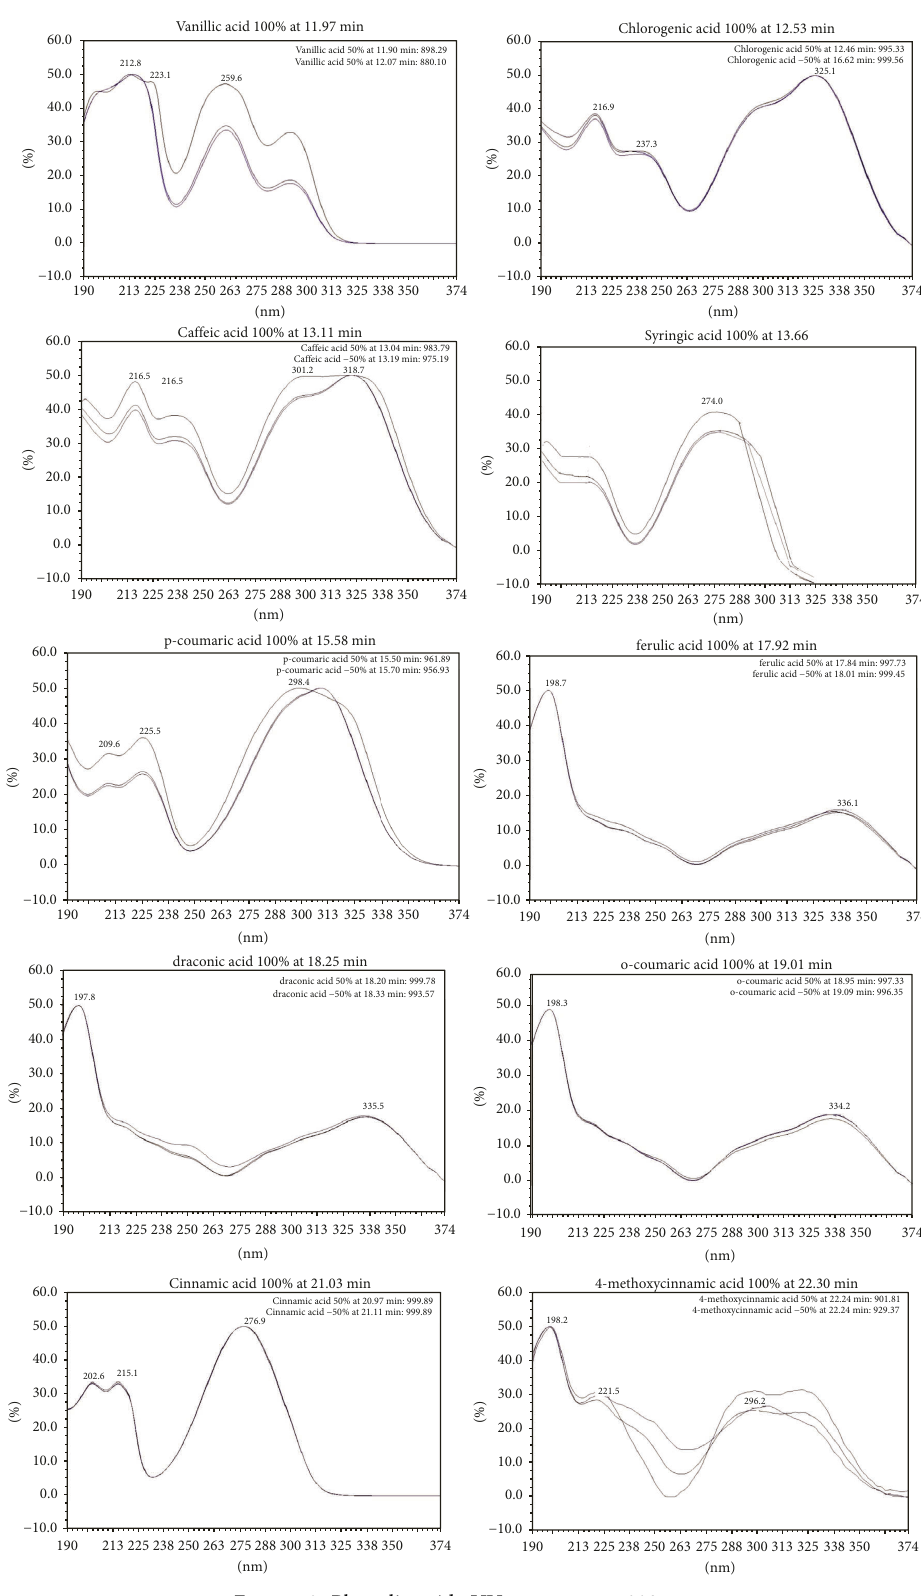
Figure 2: Phenolic acids UV spectrum at